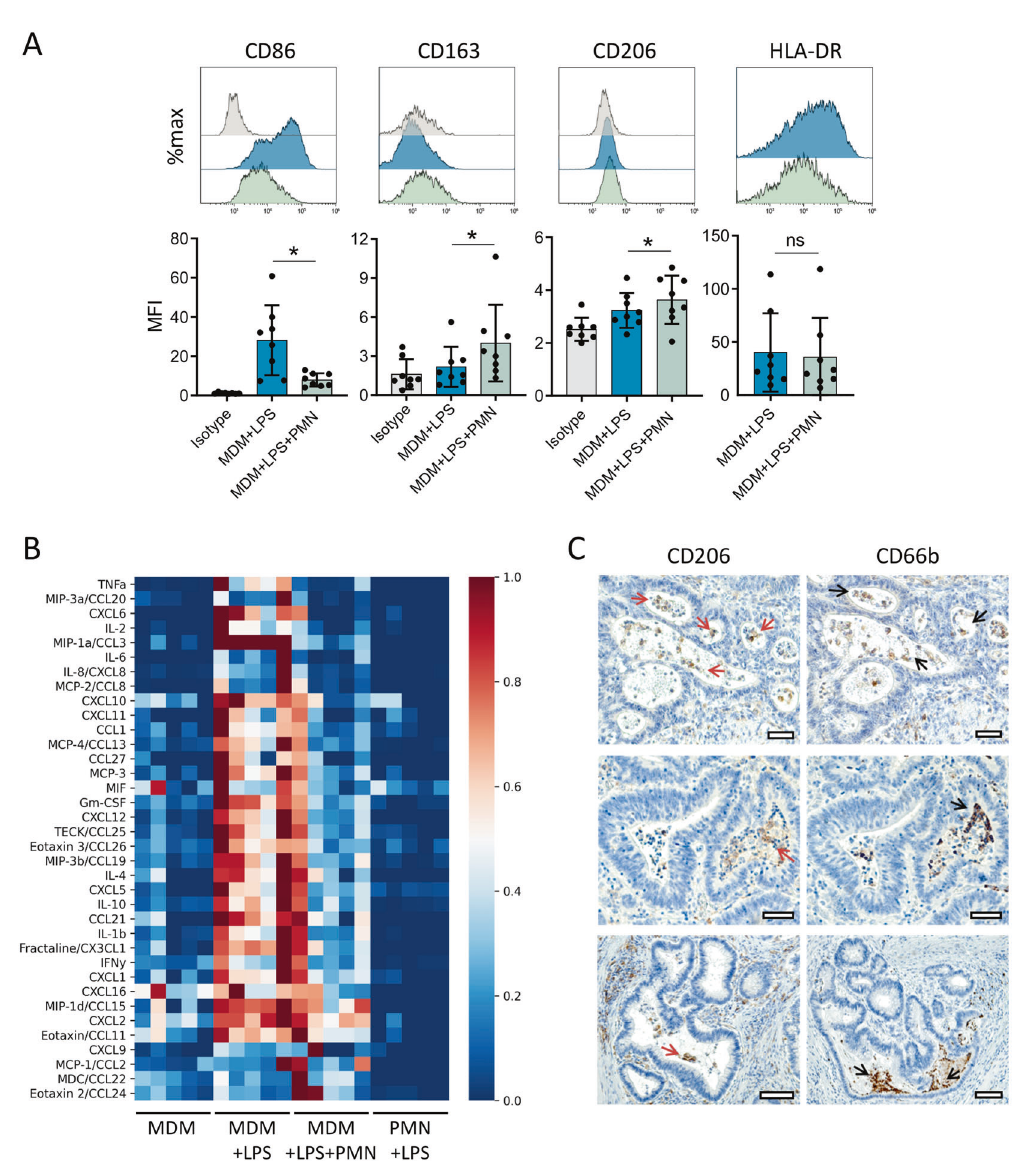
Fig. 5 Neutrophils induce anti-in fl ammatory macrophage polarisation. A Surface marker alterations of LPS-stimulated (1 ng/ml) monocyte- derived macrophages (MDM) following 18 h of co-culture with autologous polymorphonuclear neutrophils (PMN), as analysed by fl ow cytometry ( n = 8). For gating strategy, see Fig. S7B. Graphs present mean ± SD. * P < 0.05, ns not signi fi cant, as calculated by two-tailed paired t - tests. B Heatmap visualising cytokine levels in supernatants of LPS-stimulated (1 ng/ml) MDMs co-cultured for 6 h with autologous PMNs at a 1:5 ratio, as analysed using a multiplex immunoassay ( n = 5). Cytokine concentrations were normalised to a 0 – 1 scale (0, blue; 1, red) and sorted by fold-change (MDM + LPS vs. MDM + LPS + PMN). C Consecutive IHC sections of three CRC specimens stained for CD206 and CD66b. Red and black arrows indicate positive CD206 and CD66b staining in CRC pseudolumina, respectively. Scale bars, 50 µm.